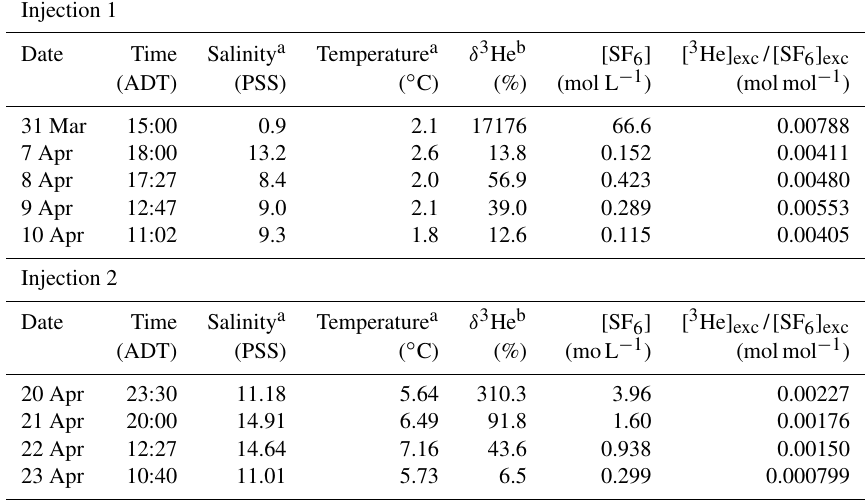
Table 2. Data for determination of the gas transfer